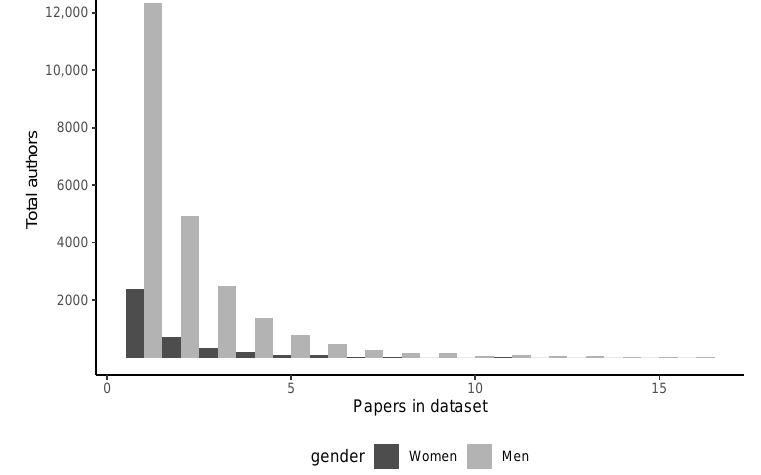
Figure 2. Distribution of number of distinct papers per